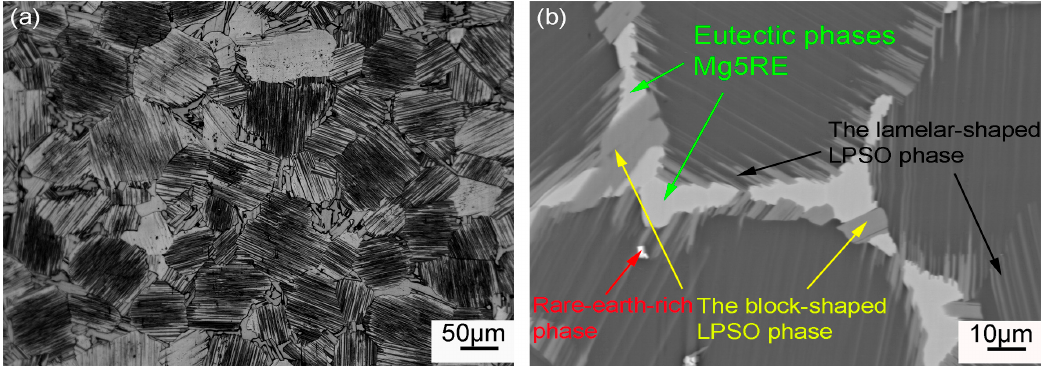
Figure 3. Microstructure of the Mg-13Gd-4Y-2Zn-0.5Zr alloy after homogenization treatment: ( a ) OM, ( b ) SEM.